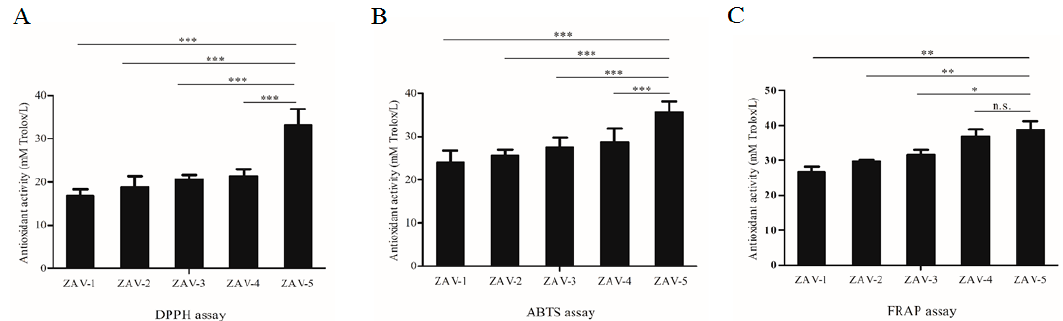
Figure 1. Total antioxidant activity of Zhenjiang aromatic vinegar (ZAV) measured by three different assays. ( A ) DPPH assay, ( B ) ABTS assay, ( C ) FRAP assay. All data are expressed as mean ± S.D. ( n = 6). * p < 0.05, ** p < 0.01, *** p < 0.001 vs. ZAV-5, n.s. indicates no significant difference.